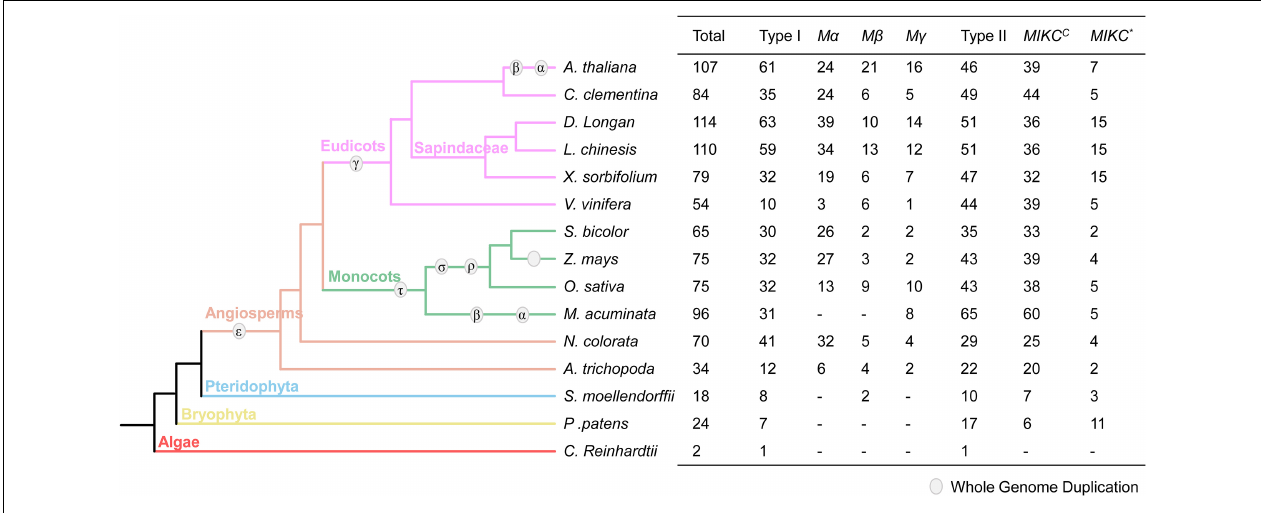
FIGURE 1 | The MADS-box gene family in 15 species. The evolutionary relationship of 15 species on the left of the figure was obtained from NCBI (https://www.ncbi.nlm.nih.gov/Taxonomy/CommonTree/wwwcmt.cgi). The right of the figure shows the number detail of the MADS-box family in each species. Type I MADS-box genes contain three groups: M α , M β , M γ , and type II genes are subdivided into MIKC C and MIKC*